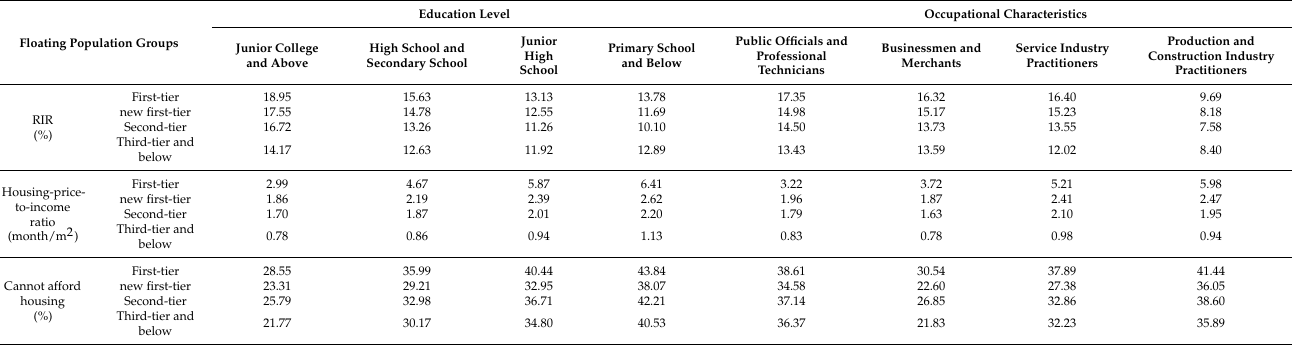
Table 7. Housing-price-to-income ratio and house affordability ratio of groups with different educa- tion levels and occupational characteristics,